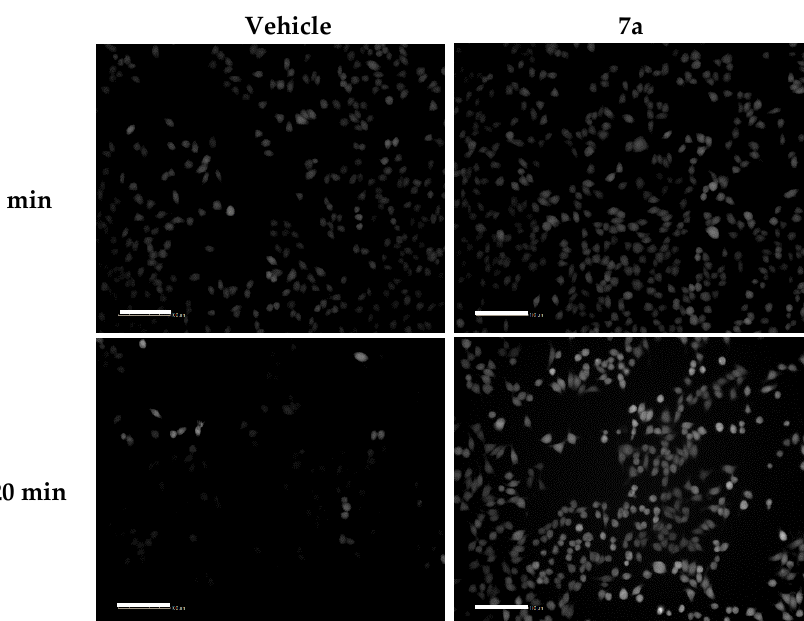
Figure 3. Changes in DAF-FM fluorescence intensity in response to compound 7a and vehicle (DMSO). Images are representative from five independent experiments, scale bars = 100 µm. DAF-FM fluorescence is shown in grey scale; contrast and brightness were uniformly adjusted and applied for each compound over the two time periods. Images were taken at 20× high numerical aperture (0.7 NA) on Perkin Elmer Operetta.